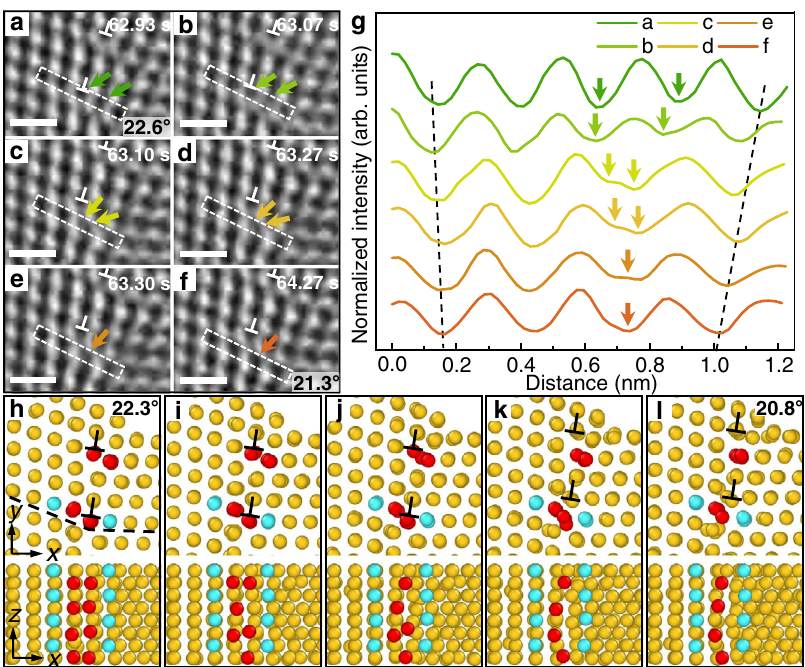
Fig. 3 Reconstruction of dislocation cores during positive climb. a – f A series of HRTEM images showing the reconstruction of a dislocation core. Scale bar: 0.5 nm. g The corresponding contrast intensity pro fi les extracted along the dotted rectangles in a – f . h – l GCMC results revealing the atomic structure evolution of dislocation cores during positive climb. The upper row of images shows the top view ( xy -plane) of the merging process of two adjacent atomic columns (colored in red) at the core of each of two GB dislocations (marked by symbol ⊥ ). The lower row shows the corresponding side view ( xz -plane) generated by cutting the atomic structure along the black dotted line in h . Another two neighboring atomic columns (colored in cyan) serve as a reference and are not directly involved in the reconstruction process at the climbing dislocation core. atomic spacing out of its original {111} slip plane. Figure 3g shows the corresponding line pro fi les of normalized intensity across the dislocation core, as extracted from the rectangles enclosing a {111} atomic layer in Fig. 3a – f. While the inter- pretation of HRTEM contrast and associated line pro fi les can be